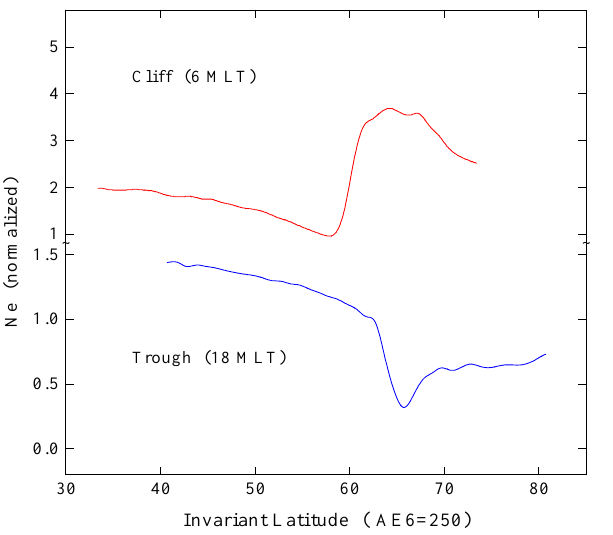
Fig. 13. Mean electron density profiles as obtained for two differ- ent local time sectors. The upper red curve refers to the morning sector and represents the mean polar cliff profile given in Fig. 10. The lower blue curve refers to the evening sector and represents the mean trough profile derived in (Pr¨olss, 2007).